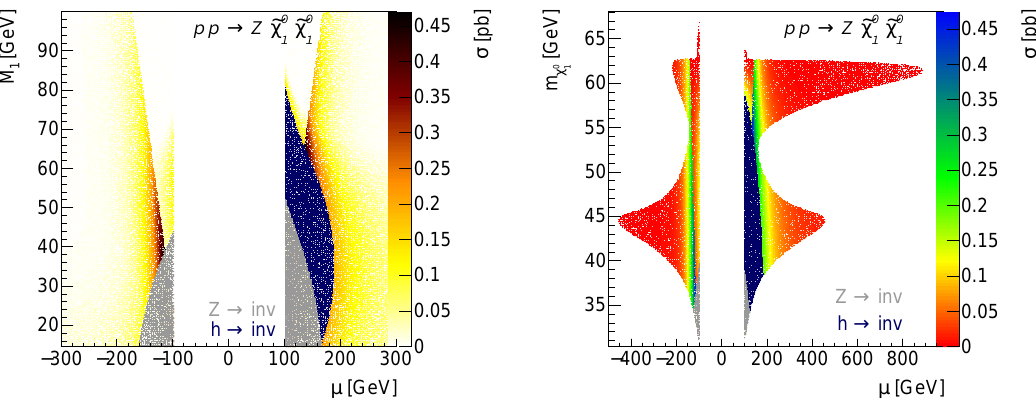
Figure 6: Cross section profiles for the mono- Z process in the µ − M fulfill the chargino mass bound (left) and, in addition, predict at most the measured relic density (right). Regions excluded by invisible Z and Higgs decays are shown in light gray and dark